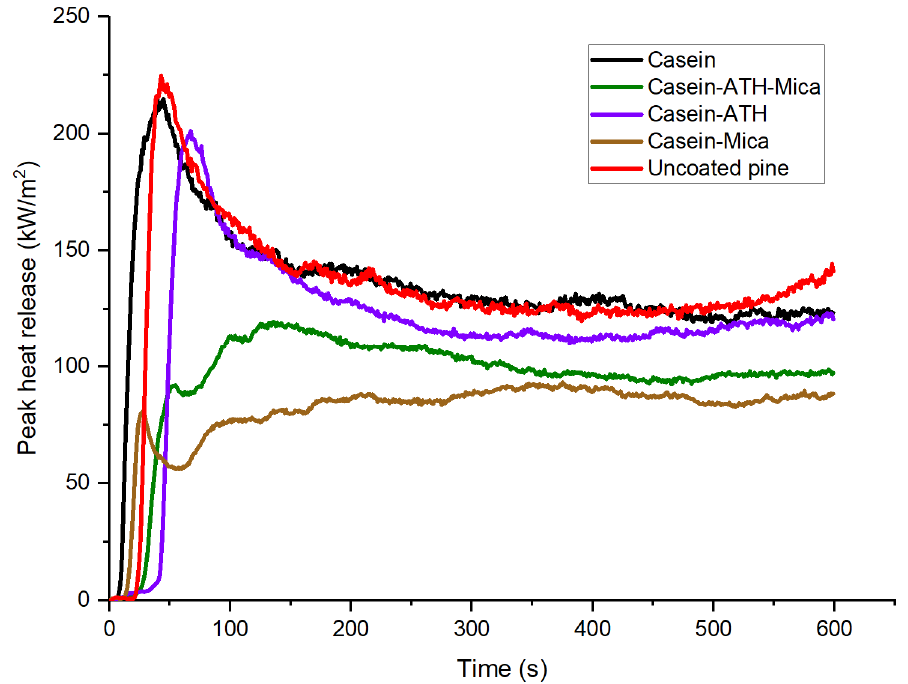
Figure 5. The heat release rate for uncoated (reference) and coated wood samples.